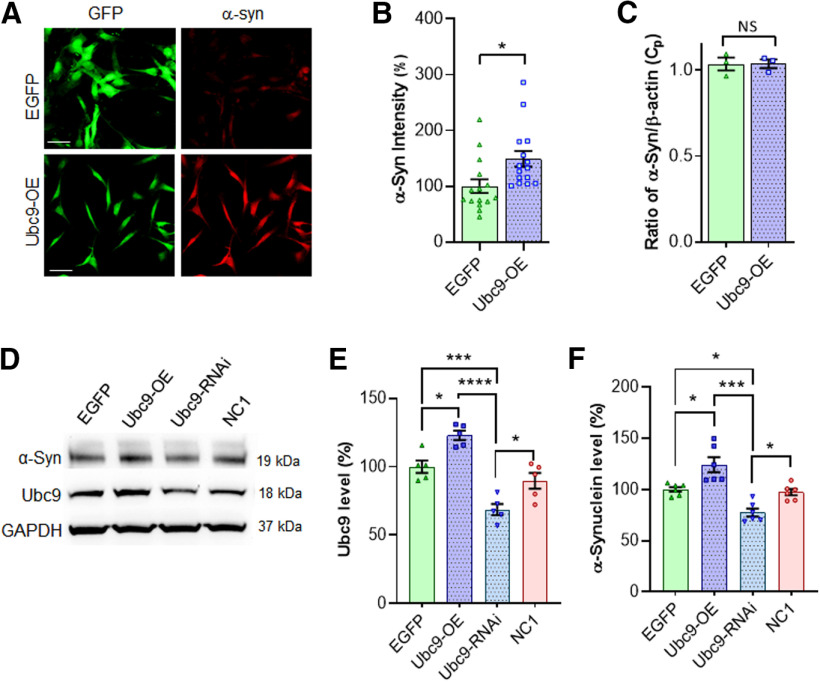
Ubc9 overexpression increases the endogenous level of α-syn protein in dopaminergic N27 cells. A, Immunofluorescent signals for α-syn and EGFP in N27 cell lines stably expressing either Ubc9-EGFP or EGFP, are shown as indicated. Image scale bar: 20 μm. B, In the quantification of fluorescence intensity of endogenous α-syn in immunocytochemistry, higher level of α-syn was detected in Ubc9 cells than in EGFP cells (n = 15). Statistical analysis was applied to Student’s unpaired t test. C, In the qRT-PCR, there is no difference in mRNA level of α-syn between Ubc9 and EGFP cells (n = 3 × 3). D, In WBs, the levels of α-syn and Ubc9 are displayed with the treatment of Ubc9-OE or -RNAi, in comparison to EGFP and NC1 controls. E, Ubc9 expression was upregulated by Ubc9-OE and downregulated by Ubc9-RNAi in the quantification of WBs (n = 5 per group). F, In the analysis of 24-h chase assays, the mixed Ubc9-RNAi constructs significantly reduces the level of α-syn, compared with the control (NC1) in WBs, whereas Ubc9-OE increases the level of α-syn, compared with EGFP control (n = 6). Bars represent mean ± SEM, and each dot represents the mean of each experiment, which was performed in triplicate. Statistical analysis was applied to one-way ANOVA, Tukey’s post hoc test; *p <0.05, ***p <0.001, ****p < 0.0001; ns: not significant.